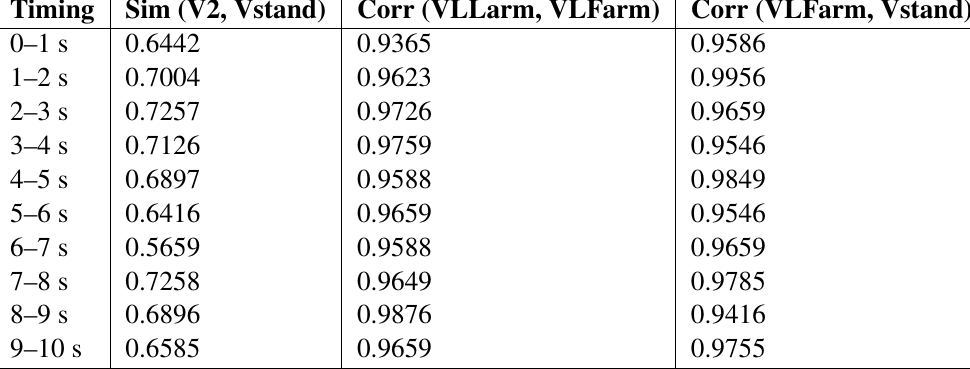
Table 3 Posture correlation parameters of the left arm standard